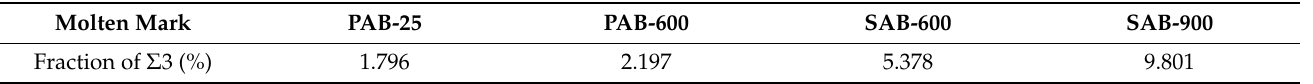
Table 2. Average fraction of Σ 3 boundaries in each molten mark.